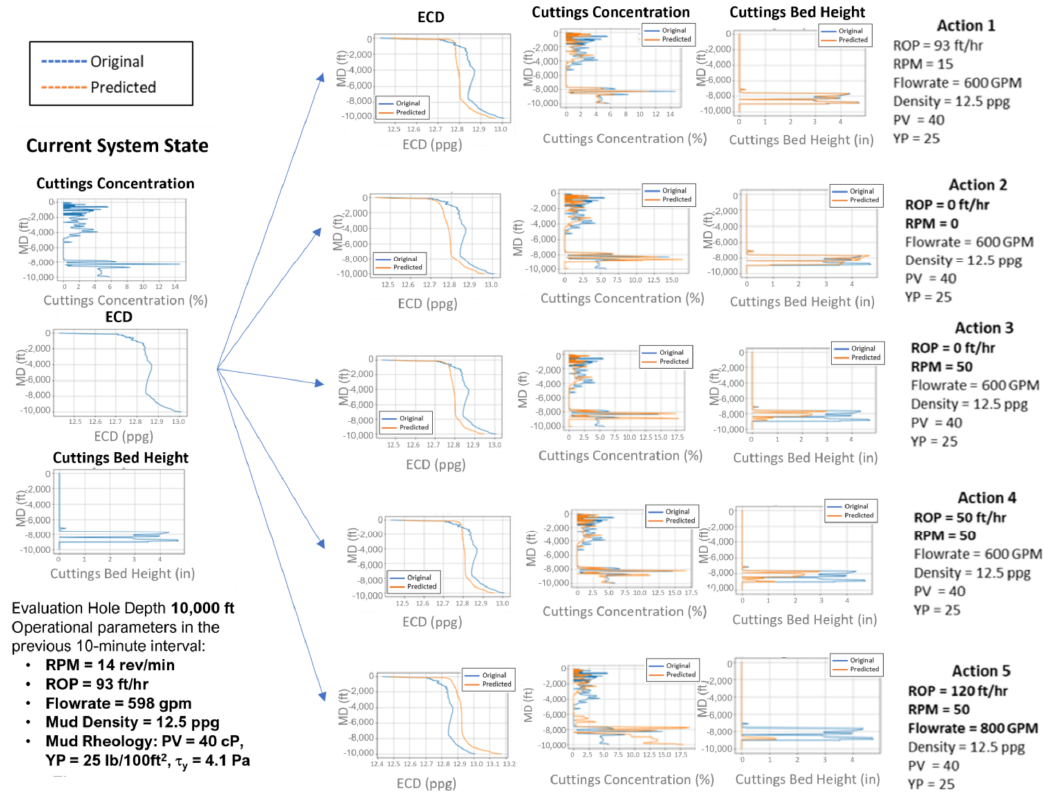
Figure 6. Scenario analysis for predictive action planning.